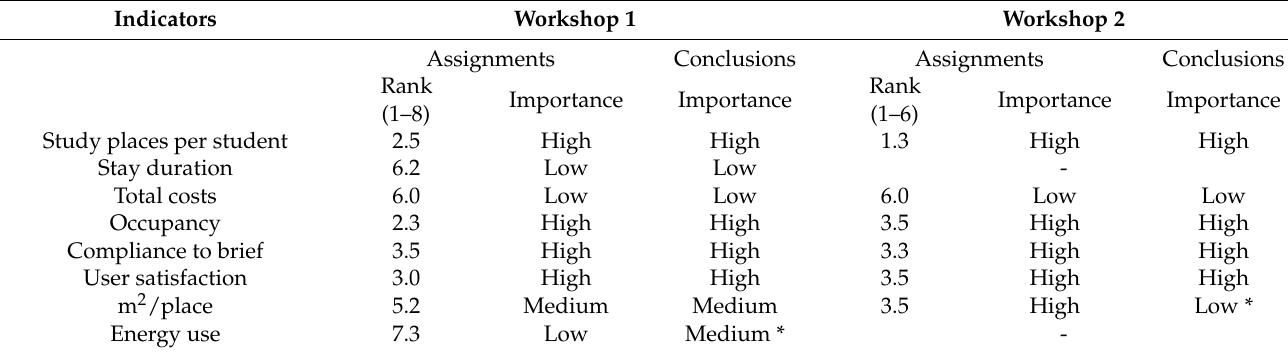
Table 5. Use of the indicators during the assignments and in forming conclusions (case RU). Asterisks (*) denote instances in which the importance based on the conclusions deviates from the importance based on the assignments.